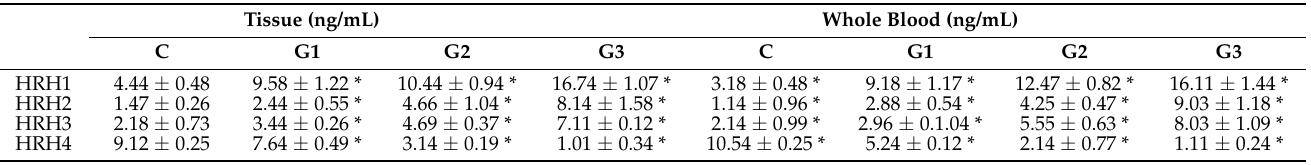
Table 7. Differences in concentration of HRH1, HRH2, HRH3, and HRH4 in endometrial cancer samples and whole blood obtained from patients with endometrioid endometrial cancer and the control (ELISA assay). Tissue (ng/mL) Whole Blood